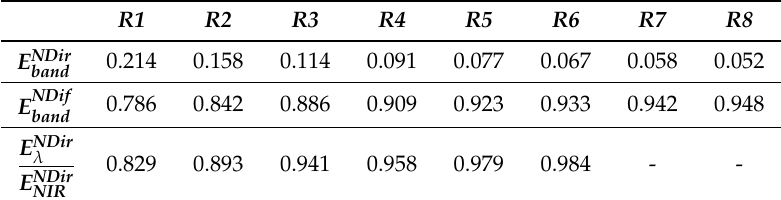
Table 2. Direct-Diffuse irradiance comparison.